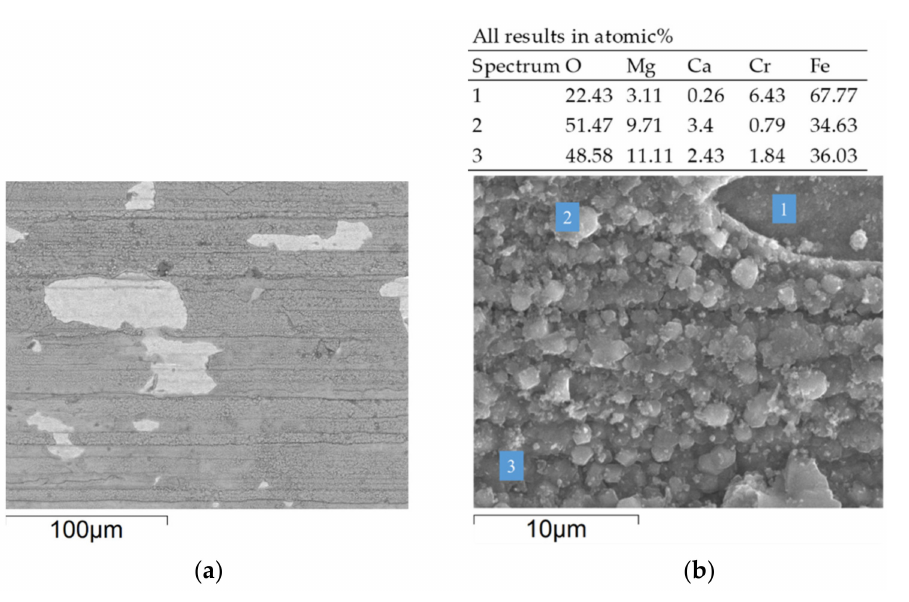
Figure 10. VM12 microstructural characterization of the surface tested in the ternary mixture 19% Ca(NO 3 ) 2 -46% NaNO 3 -35% LiNO 3 in accelerated flow conditions (0.2 m/s) at 500 ◦ C after 2000 h exposed: ( a ) 1000 × magnification with clear delamination areas; ( b ) 3000 ×